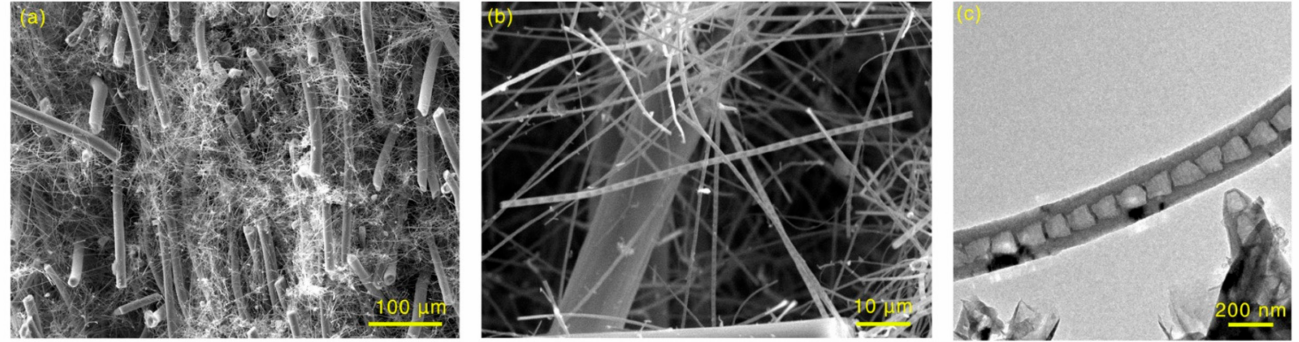
Figure 8. ( a , b ) SEM and ( c ) TEM images of CNTs in 2D needle-punched carbon fiber preform. The SEM images (Figure 9a–c) of the fracture show that the pyrocarbon matrix in C/C them. The reason for this is that, perpendicular to the direction of the layered pyrocarbon, the CTE is much higher than that of the parallel direction and carbon fibers. As a result, when it suffers thermal shock, cracks are easily generated in the layered pyrocarbon matrix. For CC/C composites (Figure 9d), many CNTs are pulled out and holes are distributed on the fracture surface. In addition, the pyrocarbon matrix completely fills the space between carbon fibers. The fracture surface of the CNT-reinforced pyrocarbon matrix is much rougher than that of C/C composites. As illustrated in the TEM image